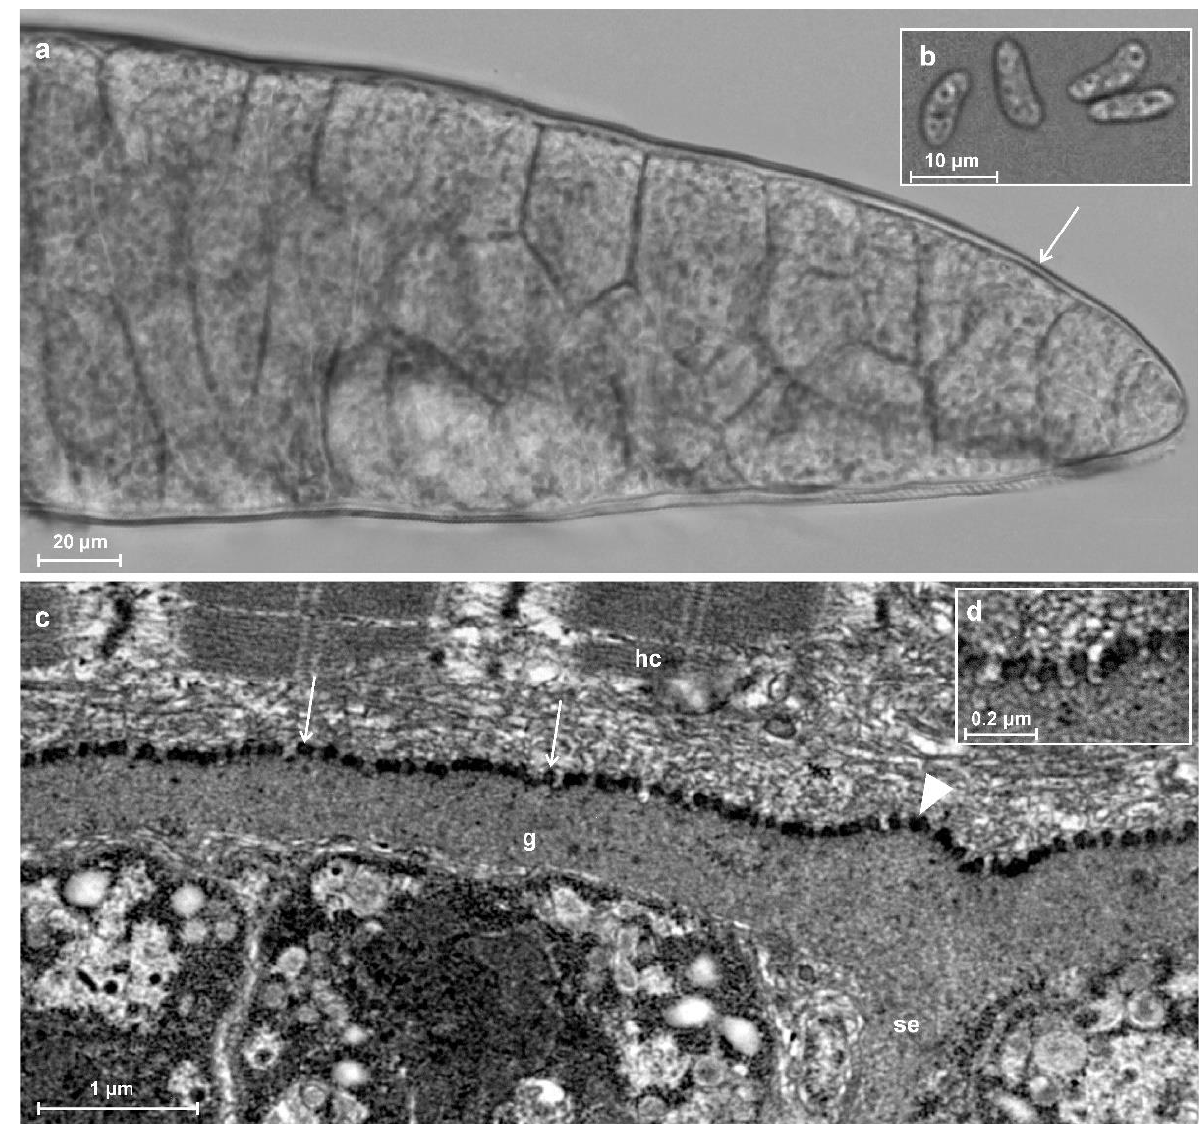
Three sarcocysts, morphologically varying in size, were isolated from the infected muscle sample. All sarcocysts had a smooth cyst wall with no visible protrusions (Figure 2a) and further molecular analysis showed that they belonged to the same species. Sarcocysts were ribbon-shaped and measured 1970 × 150 µ m (600–3000 × 70–220 µ m; n = 5). The cyst wall was thin (~1 µ m) and smooth. The septa were clearly visible. They divided sarcocysts into chambers containing numerous lancet-shaped 10.9 × 3.9 (9.6–12.0 × 3.1–4.6; n = 12) µ m bradyzoites (Figure 2b).